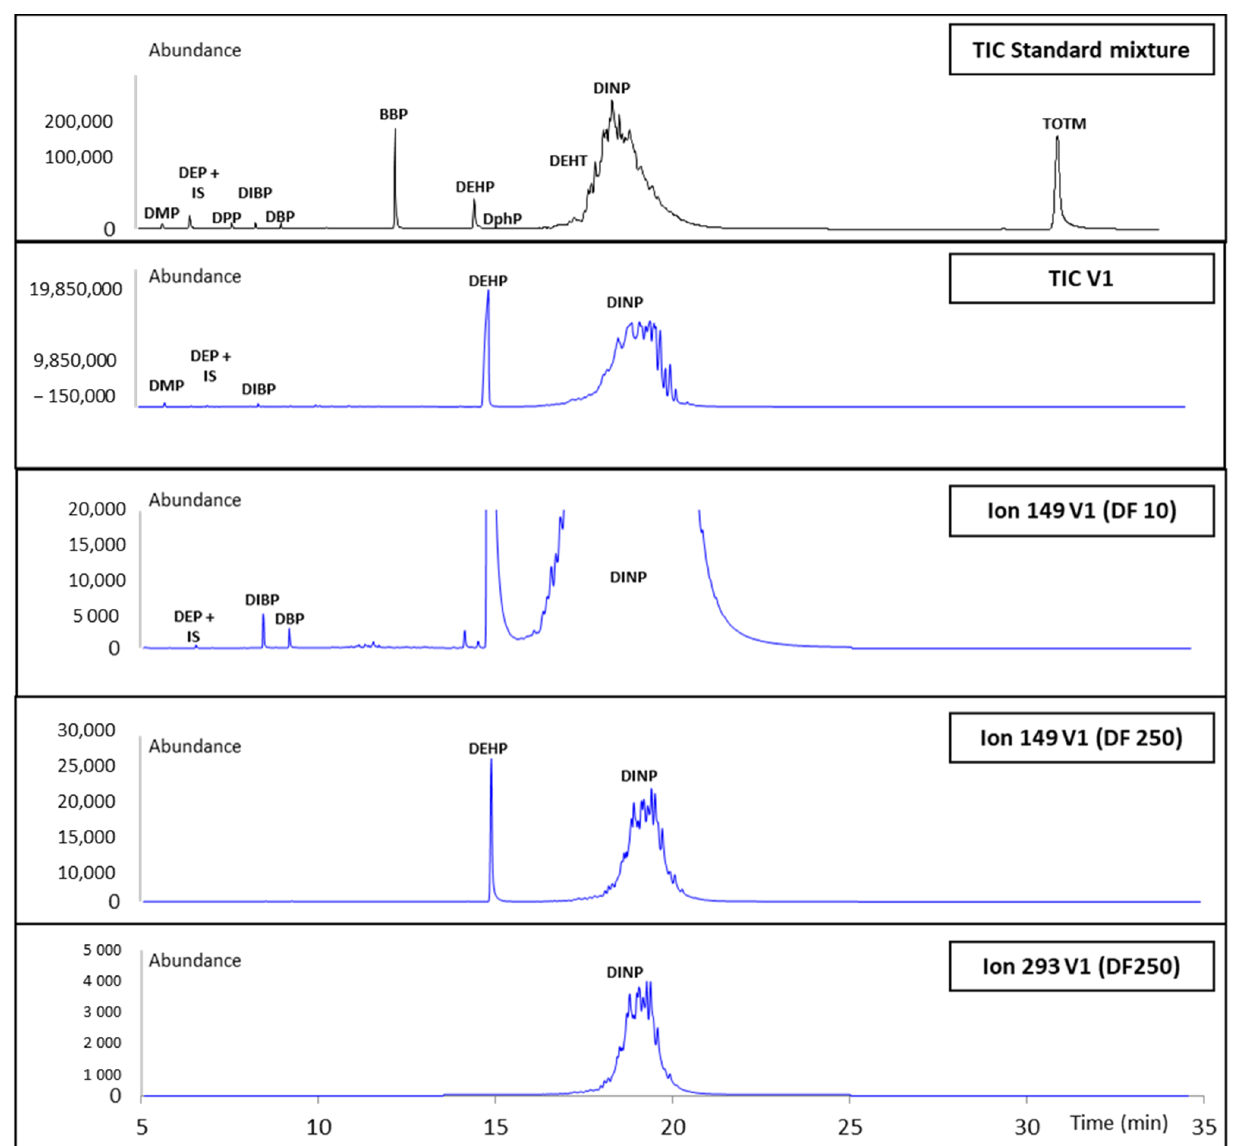
Figure 4. GC–MS chromatograms of the calibration standard SC2 (black) and a solution prepared from the V1 glove extraction (blue) at different dilution factors (DF 10 and 250). DF: dilution factor.